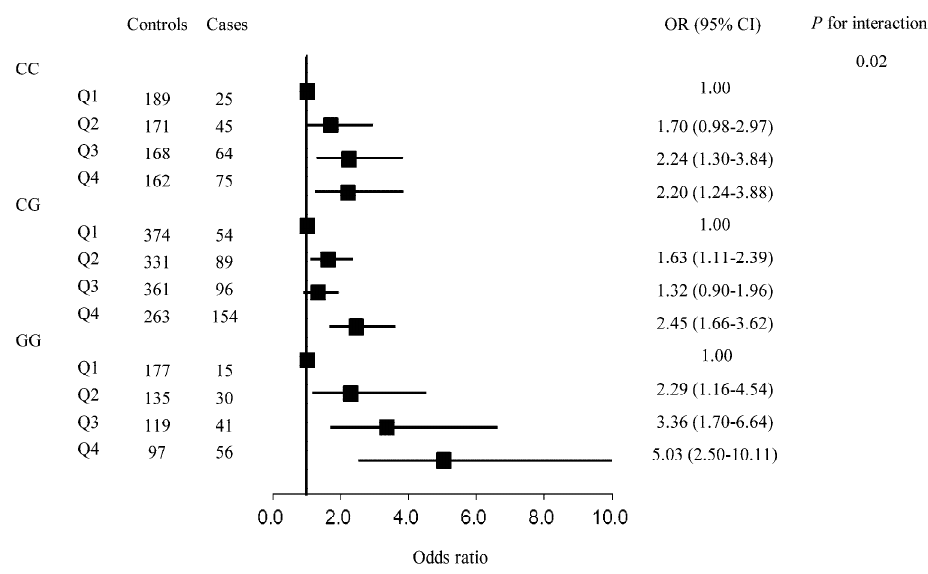
Figure 2. The association between carotid intima-media thickness (in quartiles) and large artery atherosclerosis ischemic stroke subtype stratified by rs2910164 genotype. Results were adjusted for age (continuous), sex (male, female), educational levels (less than primary school, primary school, middle school, high school, college and above, missing), body mass index (continuous), alcohol consumption (current, former, never, missing), smoking status (current, former, never, missing), type 2 diabetes (yes/no), hypertension (yes/no), and coronary heart disease (yes, no, missing).